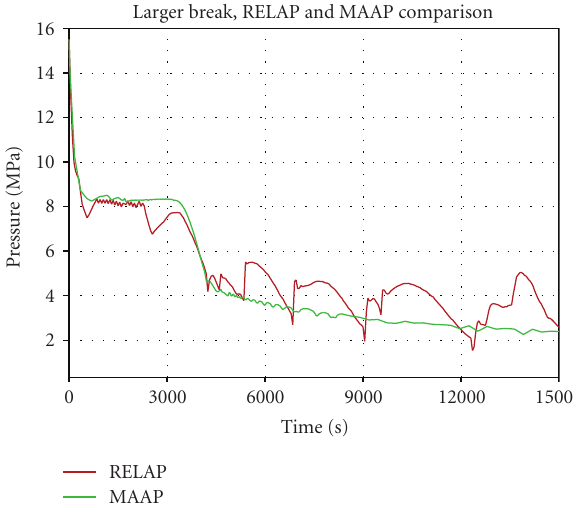
Figure 13: Collapsed water level in the reactor vessel, MAAP4 calculation, Group 2.